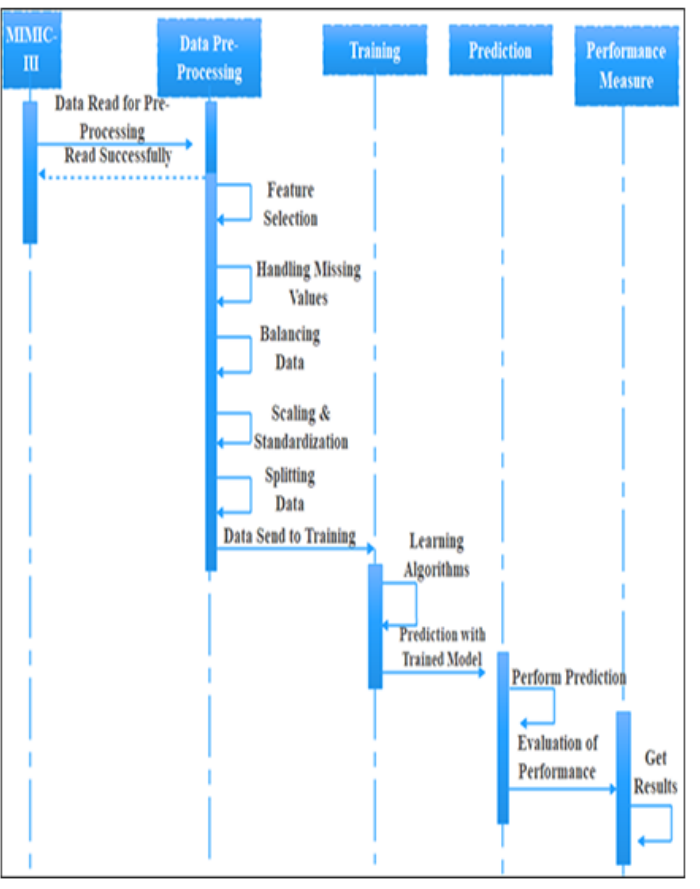
Figure 2. Sequence diagram of the proposed prediction